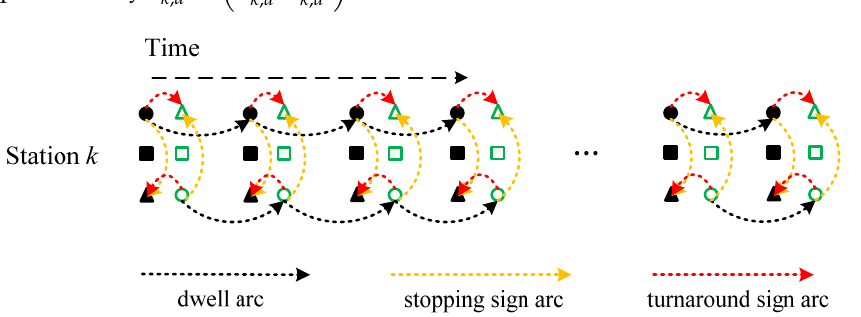
Figure 3. Dwell arc, stopping sign arc and turnaround sign arc.